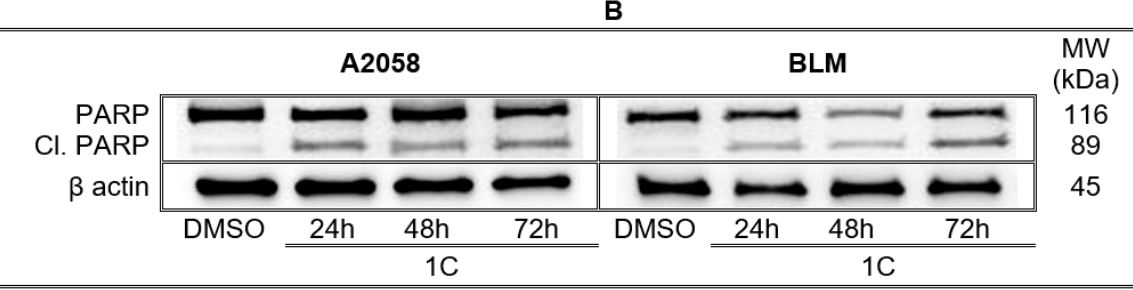
Figure 11. Induction of PARP cleavage in A2058 ( A ) and BLM ( B ) melanoma cells after 24, 48 and 72 h of treatment with chalcone 1C at concentrations of 10 μ mol/L (A2058) and 20 μ mol/L (BLM). Representative WB.